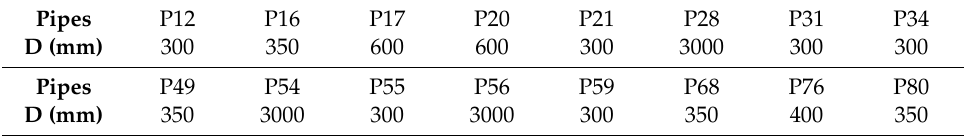
Table 6. New pipe diameters according to the zero-flooding solution of the SSR model 2.